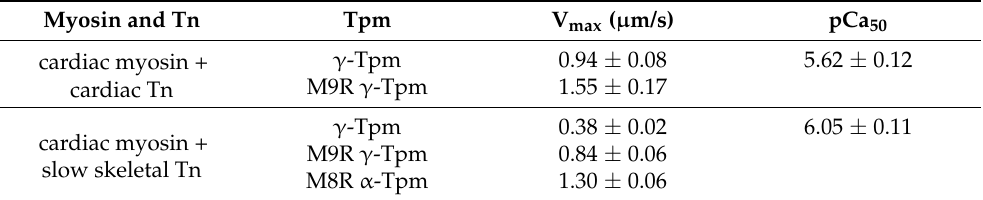
Table 4. Effects of Tpm mutations on the characteristics of the pCa-velocity dependence in the presence of cardiac or slow skeletal Tn